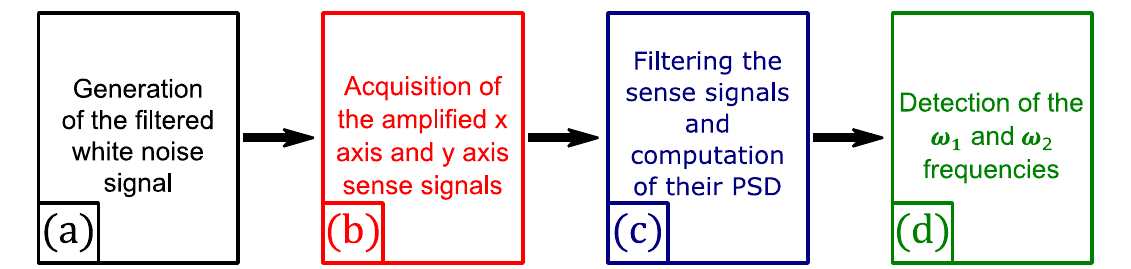
Figure 7. Scheme of the bench developed to measure the quadrature error: (a) contact with the x axis and y axis sense electrodes, (b) contact with the frequency mismatch compensation electrodes, and (c) contact with the x axis drive electrode(s).